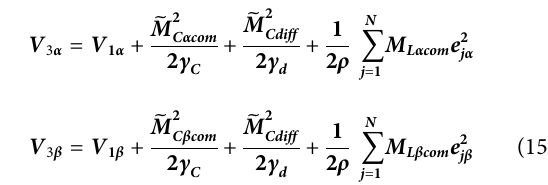
(The fi lter parameters are